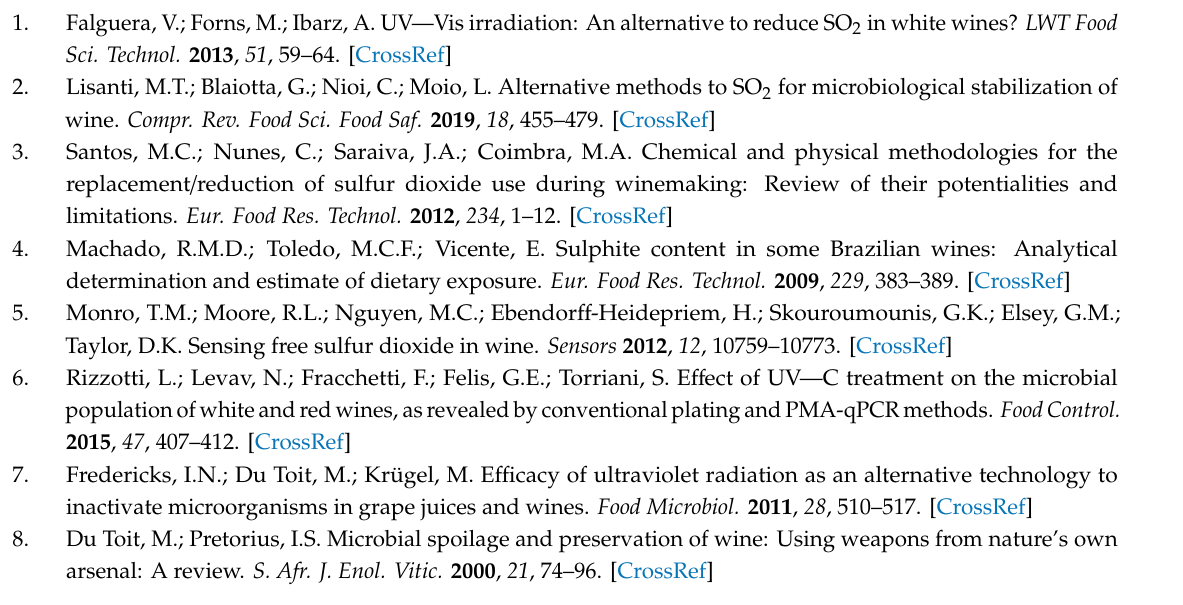
Figure S1: Thermogravimetric analysis of silica nanospheres; Figure S2: TEM images of Streptomyces cell before (a), during (b), and after interaction with silica nanostructures (c), Figure S3: TEM images of pristine silica nanospheres (a) and after exposition in wine